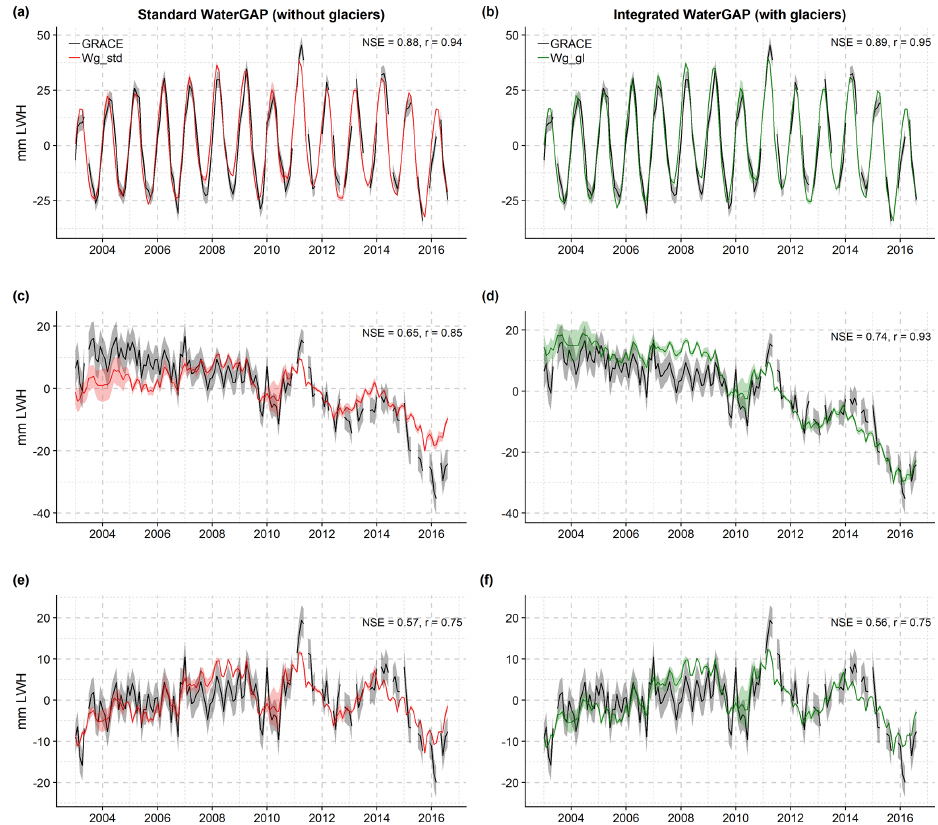
Figure 4. Temporal components of global mean monthly TWSA from GRACE observations and from two versions of WaterGAP2.2d from January 2003 to August 2016. GRACE ensemble, standard WaterGAP (Wg_std) ensemble (a, c, e) and integrated WaterGAP (Wg_gl) en- semble (b, d, f) . (a, b) De-trended anomalies. (c, d) De-seasonalized anomalies (corresponding to linear and non-linear long-term variability). (e, f) Residual anomalies obtained by removing linear trend and seasonality (corresponding to non-linear interannual variability). For each ensemble, the curve represents the ensemble mean, and the shaded area around the curve represents either the uncertainty range (GRACE) or the ensemble range (Wg_std and Wg_gl). Nash–Sutcliffe efficiency (NSE) and correlation coefficient ( r ) obtained by comparing GRACE and model ensemble means are provided. Anomalies are relative to the mean over January 2006 to December 2015 and given in millimetres of land water height